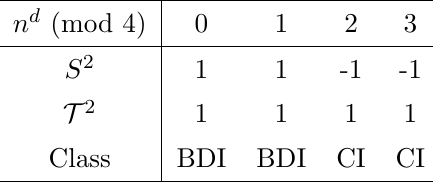
Table 3 . Symmetry classes of Gurau-Witten Hamiltonians with even m and for arbitrary n